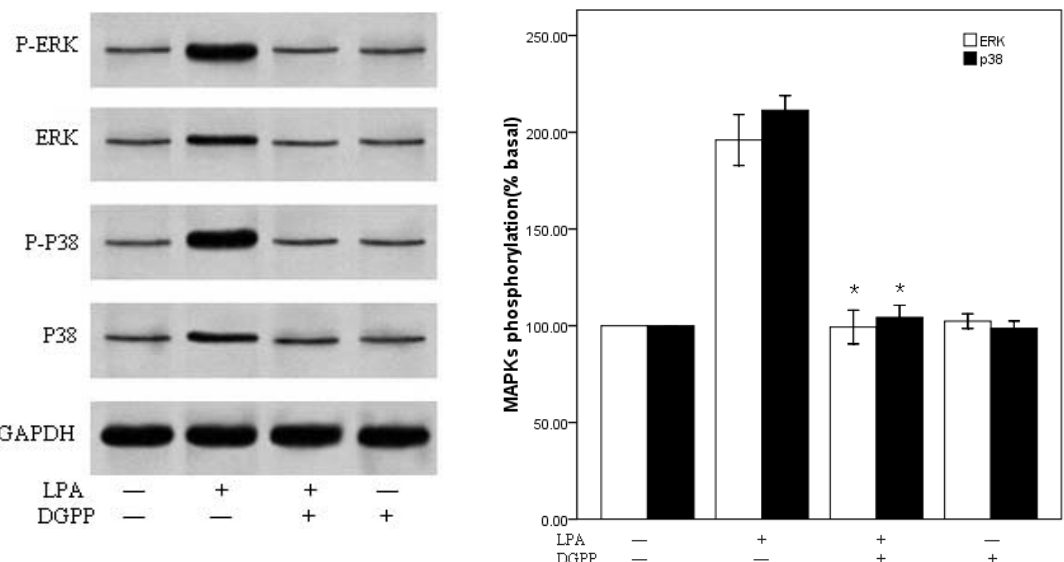
Figure 5. Effect of DGPP on p38 MAPK and ERK phosphorylation.